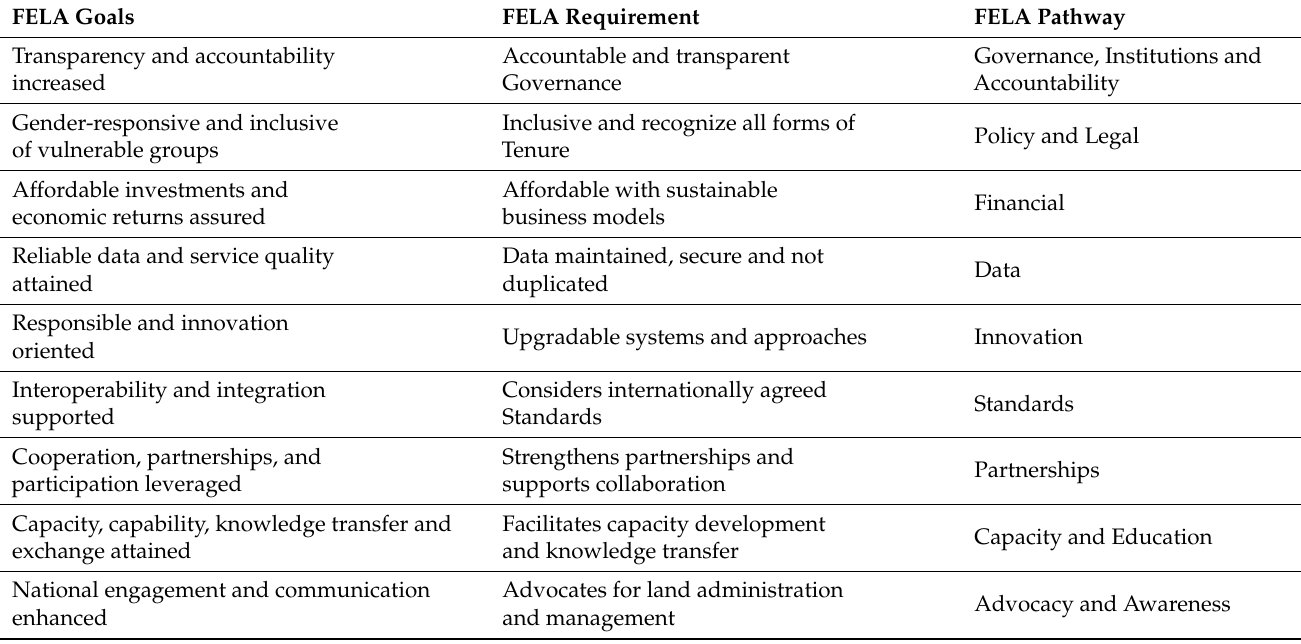
Table 1. FELA: Goals, Requirements, and Pathways [9]. From Framework for Effective Land